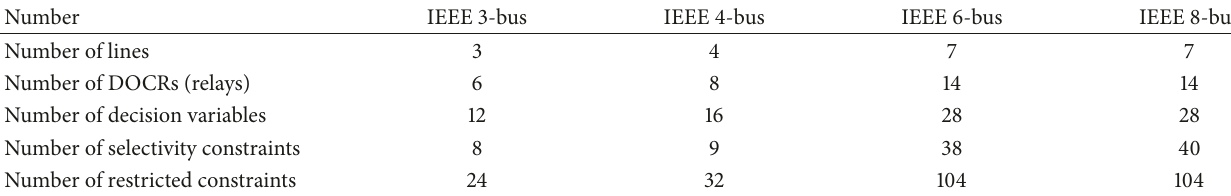
Table 6: The complexity of the DOCR problems as the bus size increases.